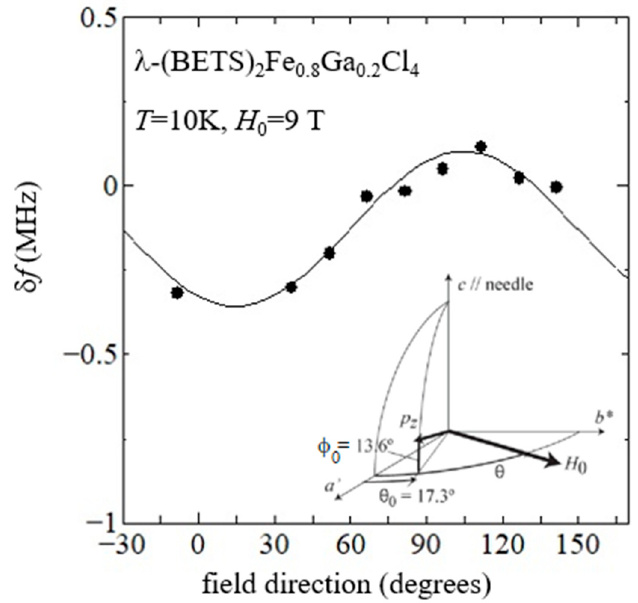
Figure 2. Angular dependence of the central shift, δ f . The solid line is the calculated angular dependence assuming the exchange interaction JM (10K) = − 20 T. The geometrical situation of the measurements is shown in the inset.